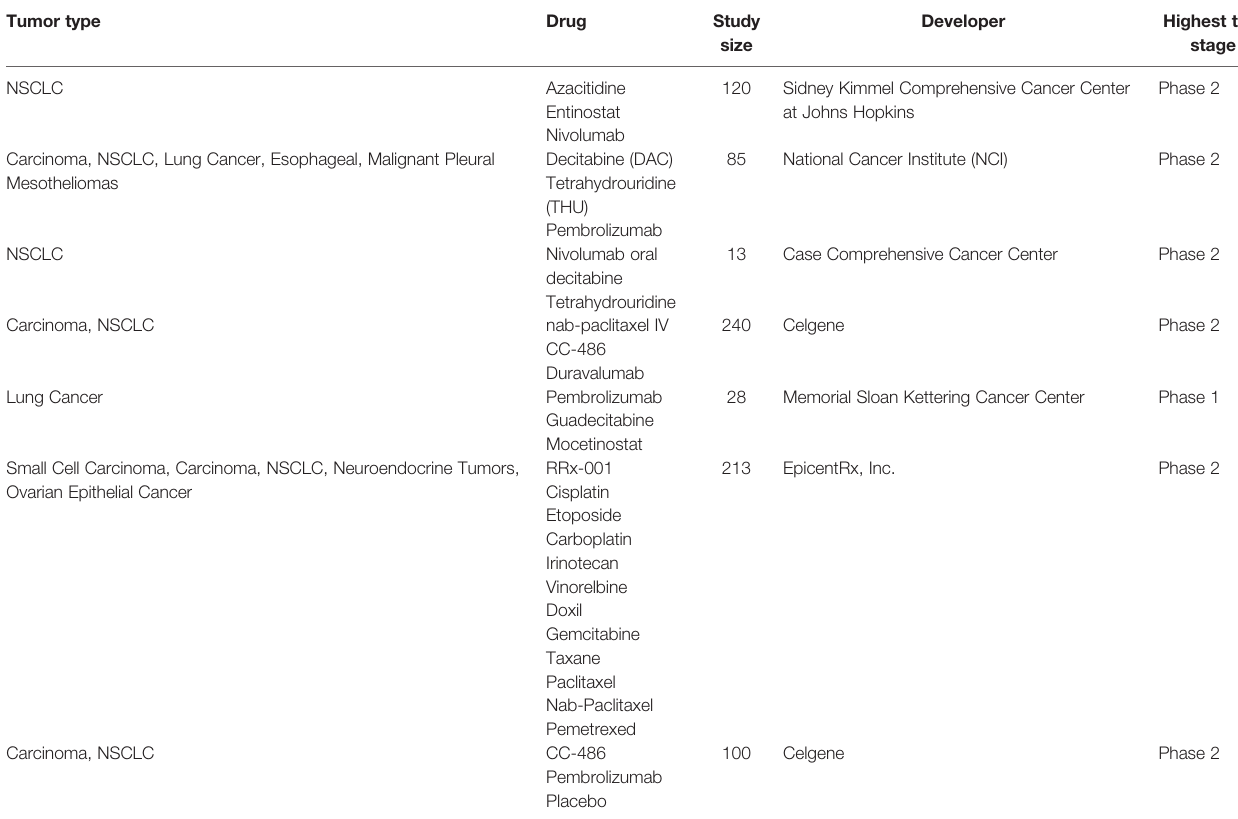
TABLE 1 | Summary of epigenetic approaches for NSCLC in clinic. Tumor